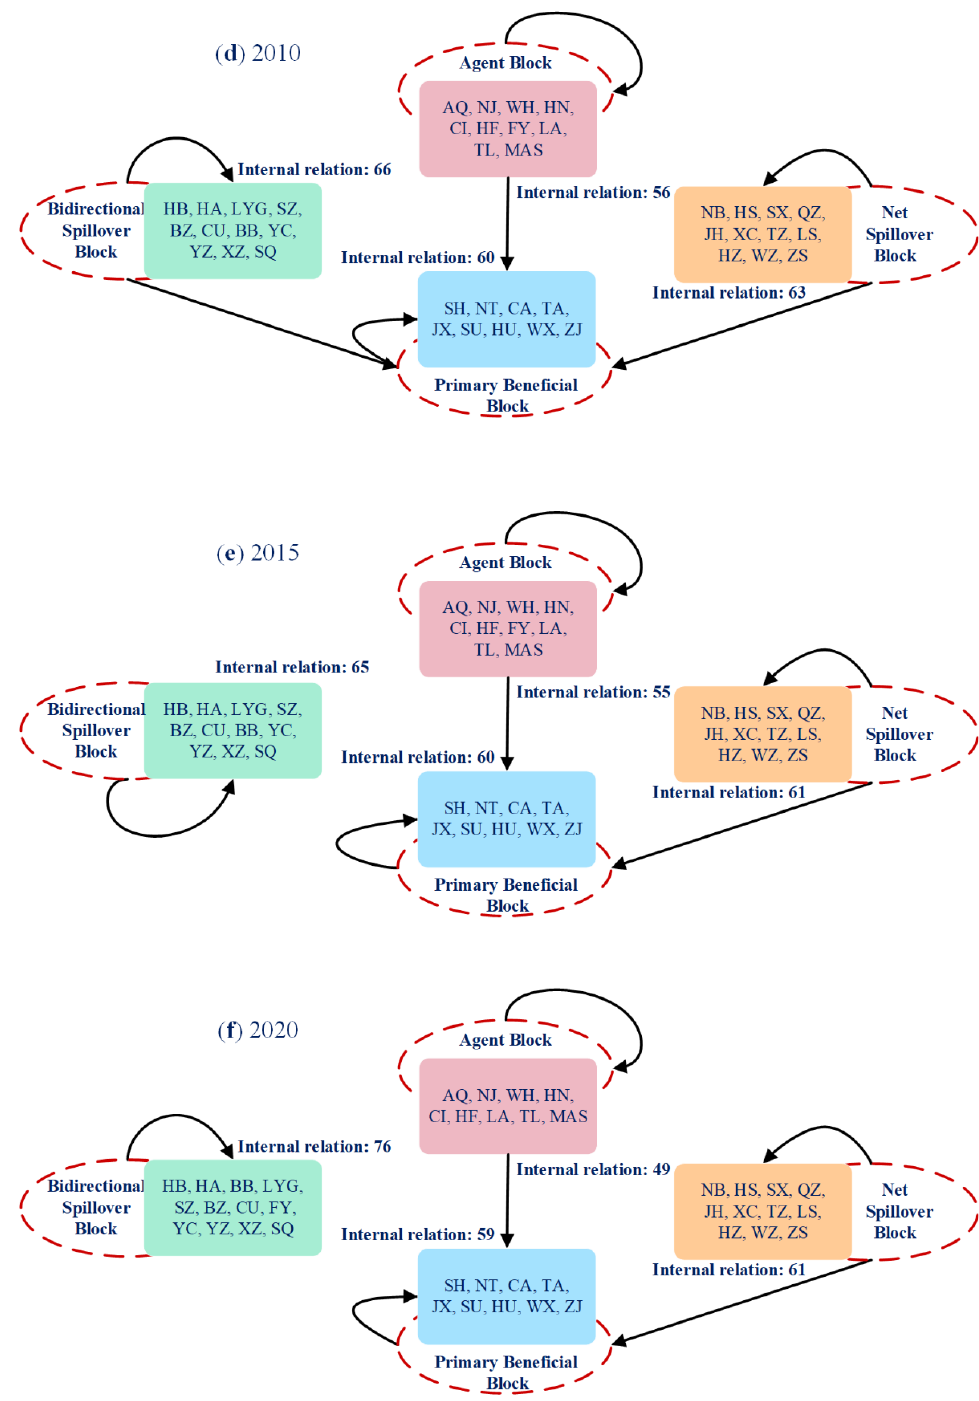
Figure 7. The transmission relationship between the blocks in ( a ) 1995, ( b ) 2000, ( c ) 2005, ( d ) 2010, ( e ) 2015 and ( f ) 2020.